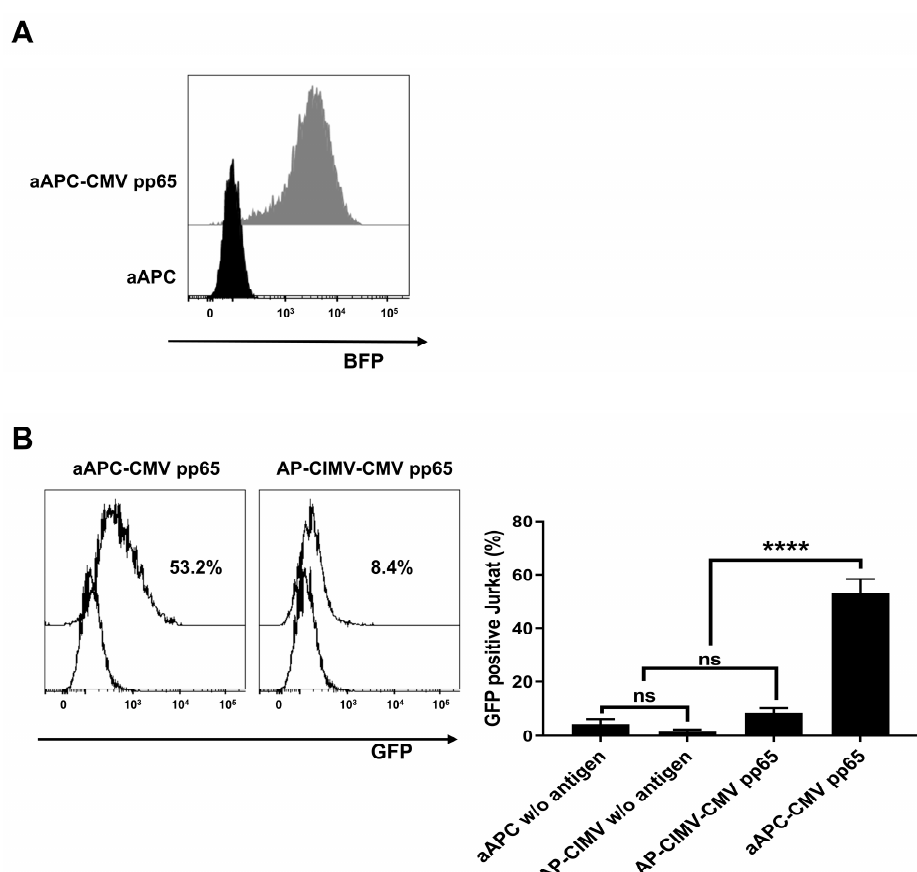
Figure 5. Activation of Jurkat reporter cells expressing specific TCR by aAPCs and AP-CIMVs presenting endogenously processed CMV pp65 antigen. ( A ) BFP co-expressed with CMV pp65 in aAPCs was analyzed via flow cytometry. ( B ) Jurkat reporter cells expressing specific TCR were stimulated with aAPCs expressing HLA-A*02:01 and CMV pp65 antigen (10:1) and their AP-CIMVs (25 ug), and then, the GFP expression was measured via flow cytometry. In the negative control group, aAPCs without antigen expression or their AP-CIMVs alone were used for stimulation. Representative data are presented. Error bars display mean values ±SD of triplicate. P value was calculated via one-way ANOVA. **** p < 0.0001.